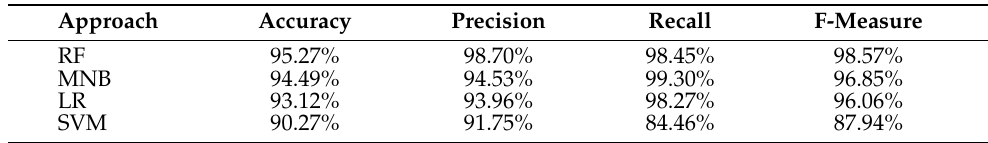
Table 3. Comparison against off-the-shelf classifiers.